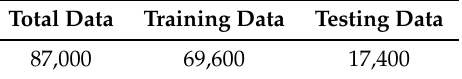
Table 3. Training/testing separation